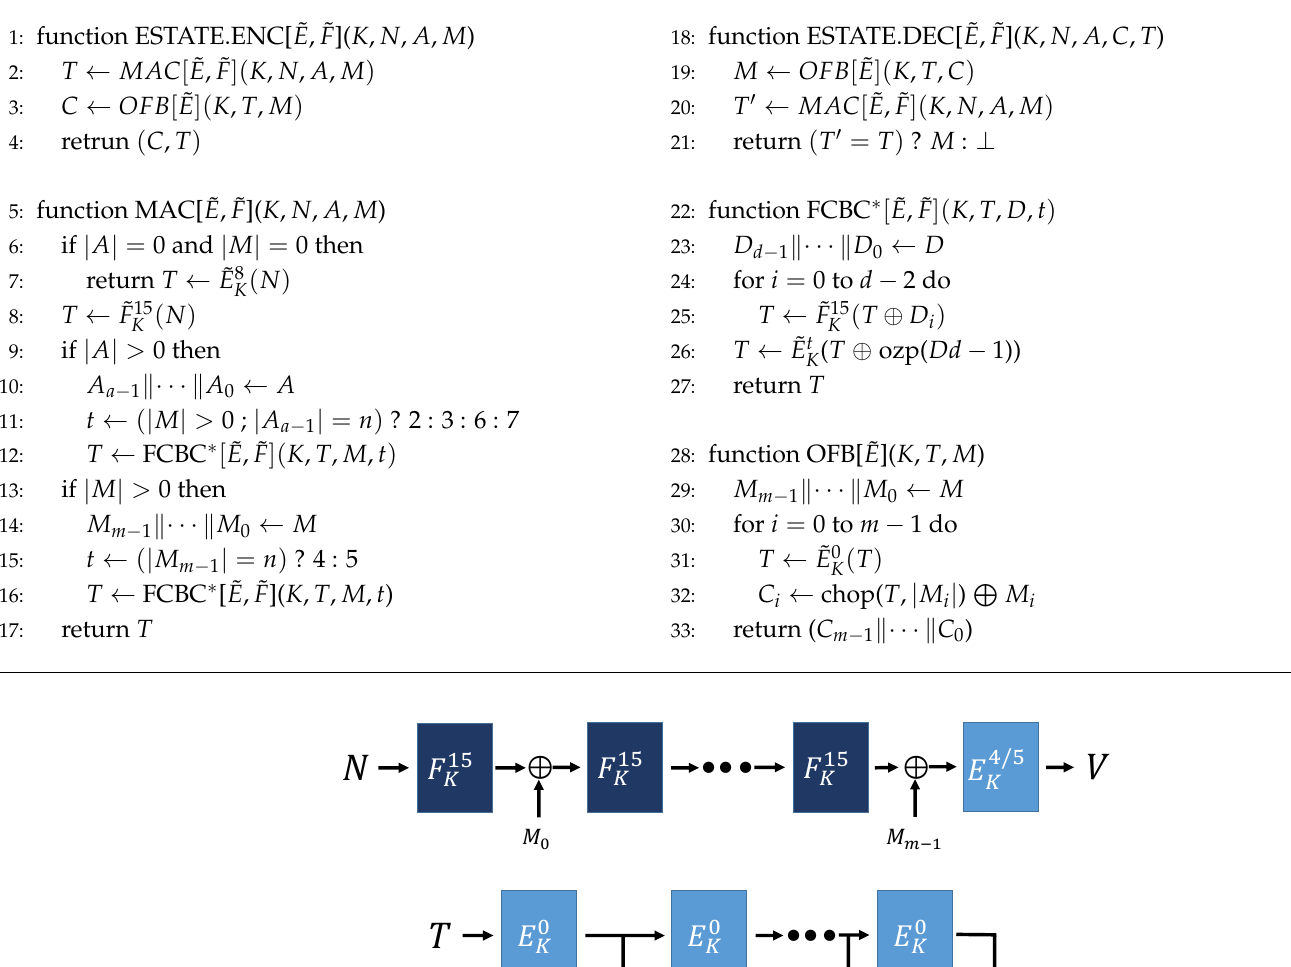
Algorithm 2 sESTATE Encryption, Tag Creation, Authentication, and Decryption Algorithm [16].